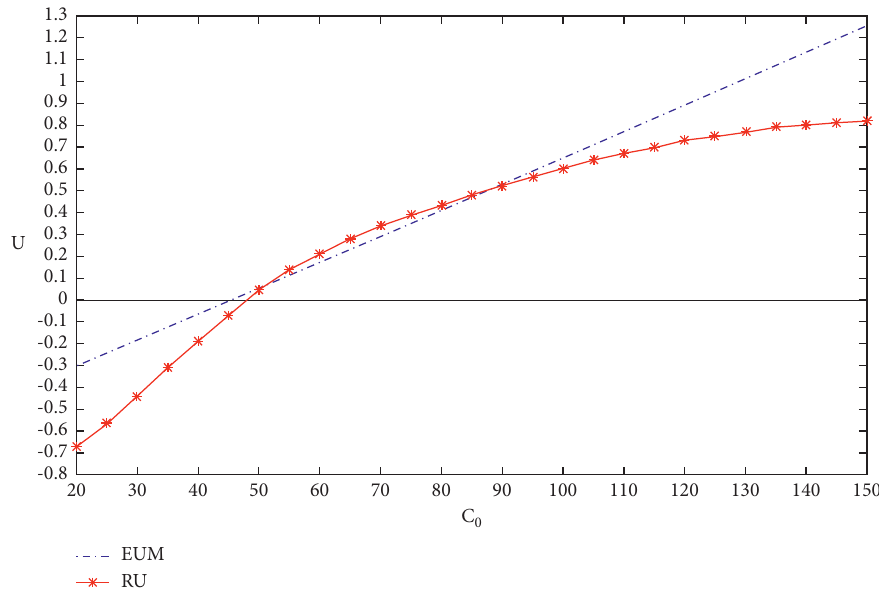
Figure 6: Comparison of RU and EUM ( T